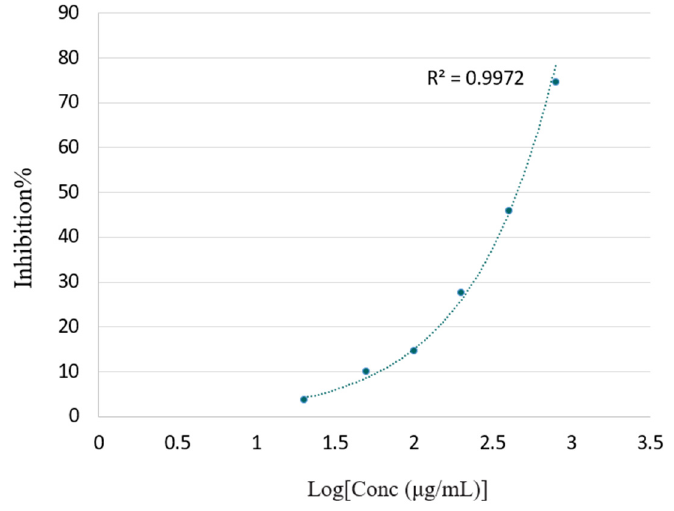
Figure 5. Percentage of the inhibitory effect of the F. hispida volatile organic compounds in the ABTS free radical scavenging assay.